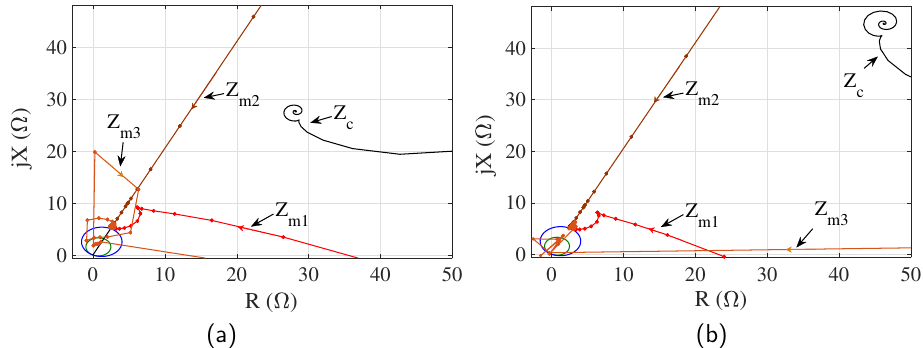
Figure 21. Impedance trajectories of the proposed and conventional methods for ( a ) 3LG and ( b ) SLG faults at 140% of the feeder’s length.